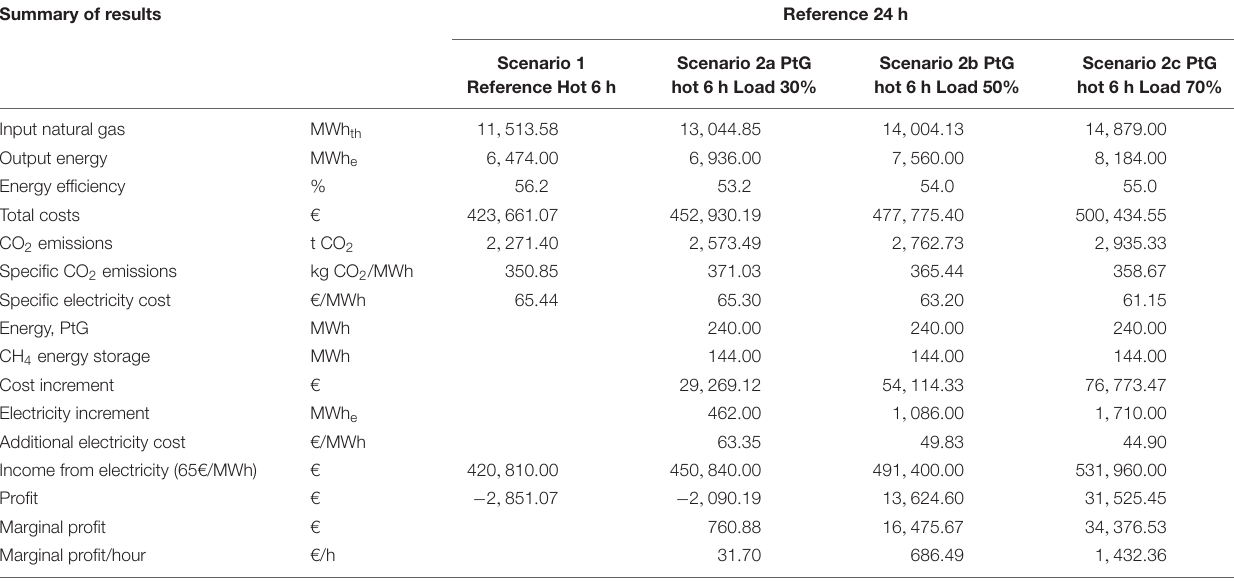
TABLE 4 | Conventional combined cycle power plant (CCPP) vs. PtG-assisted CCPP; hot start-up. Summary of results